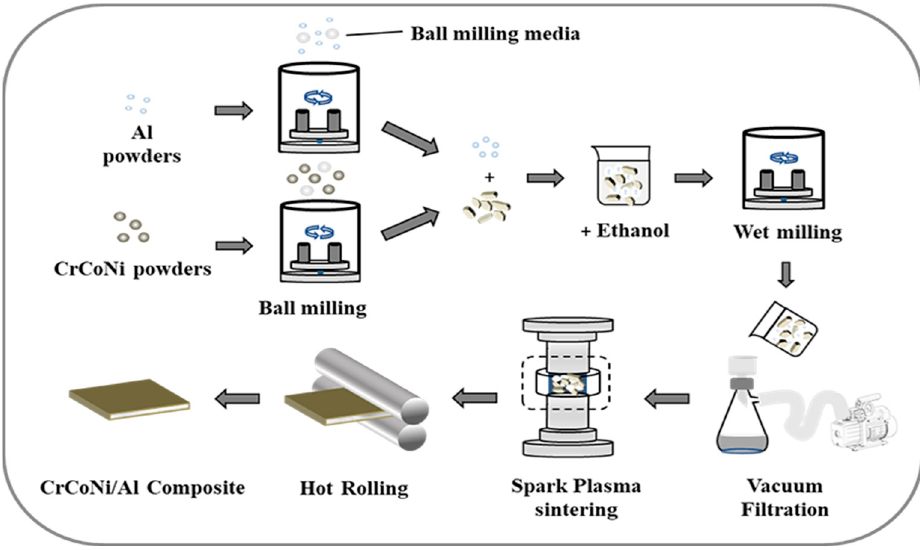
Figure 1. The schematic diagram of the fabrication processes of the CrCoNi/Al composites.